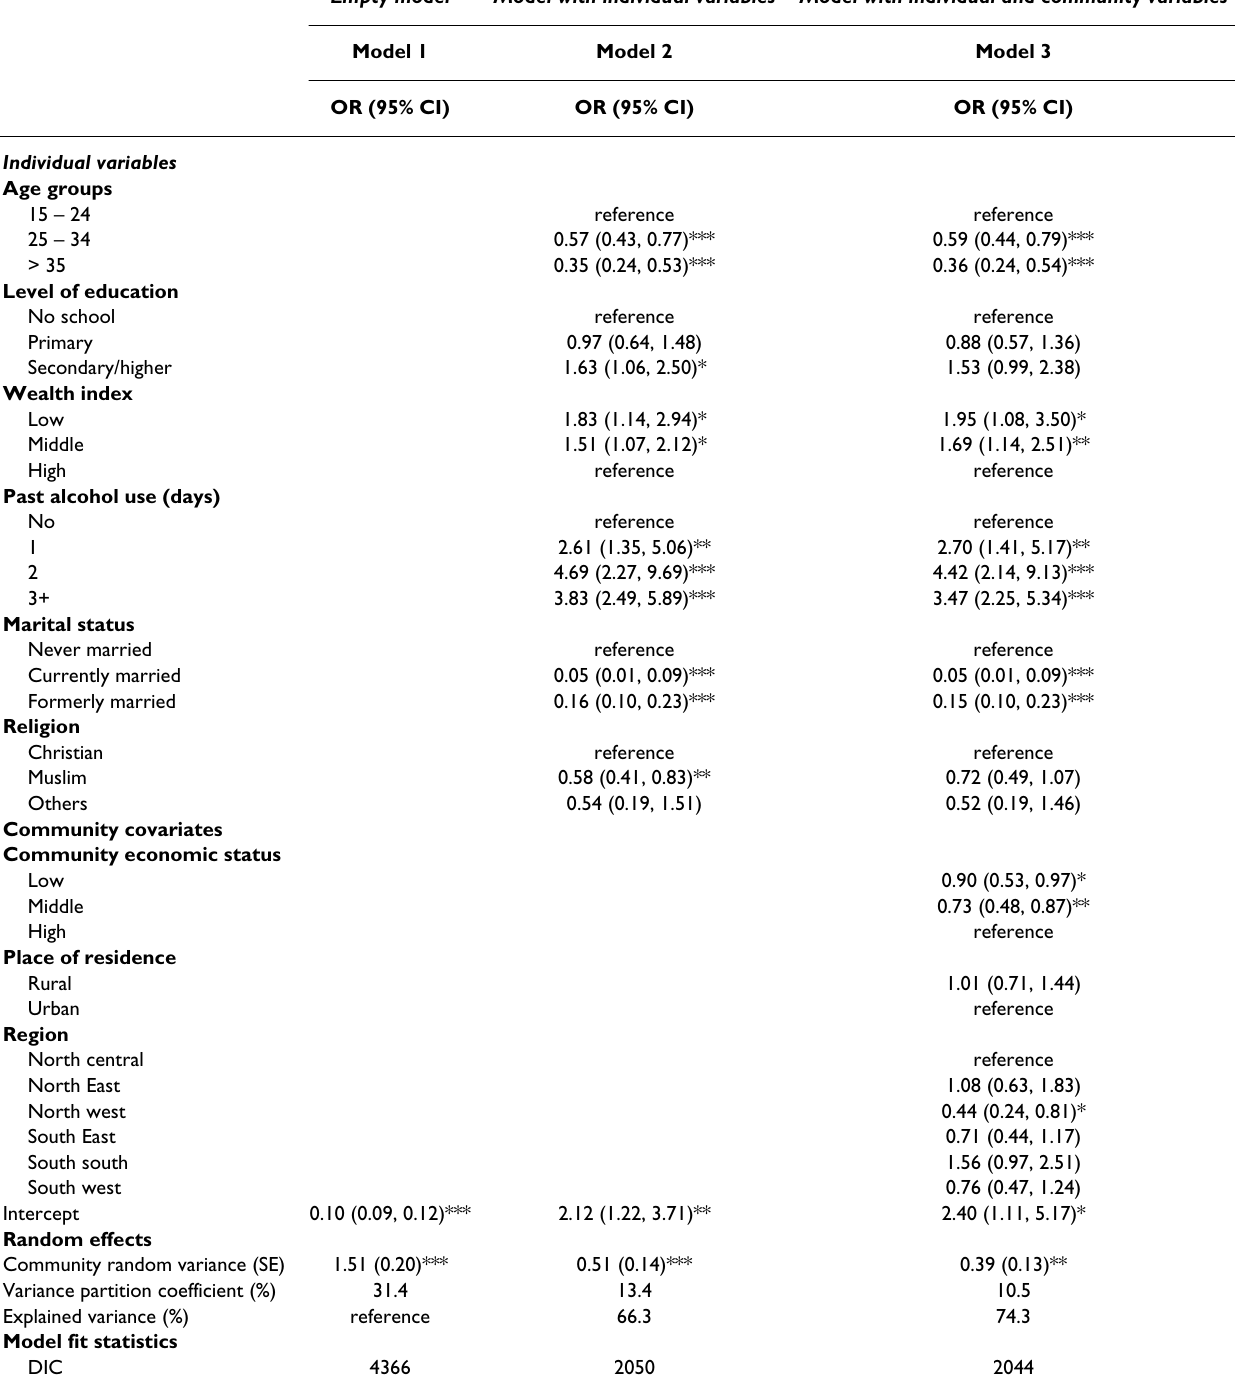
Table 2: Individual compositional and community contextual factors associated with sexual behaviour among Nigerian women identified by multivariable multilevel logistic